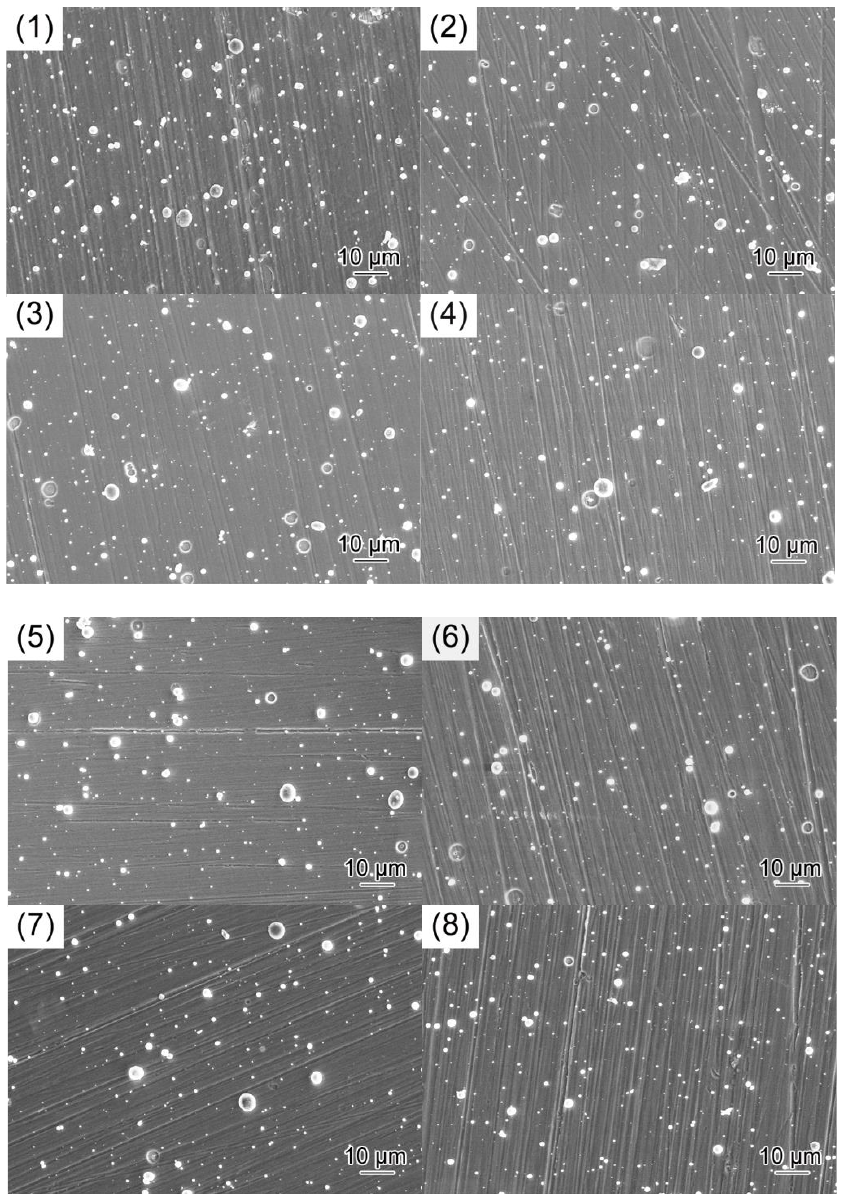
Figure 1. Surface morphologies of the deposited Ti x Zr 1−x N films. The numbers (1) – (8) correspond to sample numbers 1 – 8, respectively.